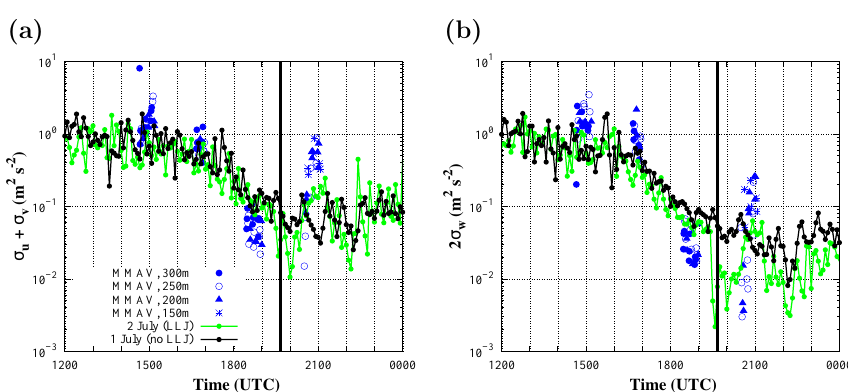
Figure 8. The same as Fig. 7 but for the (a) horizontal σ u + σ v and (b) vertical 2 σ w variances computed from the tower observations at 60ma.g.l. during 1 July 2011 (IOP 9, without an LLJ, black line) and 2 July 2011 (IOP10, with an LLJ, green line), together with those derived from M 2 AV observations. For M 2 AV data, σ 2 u = σ 2 v is